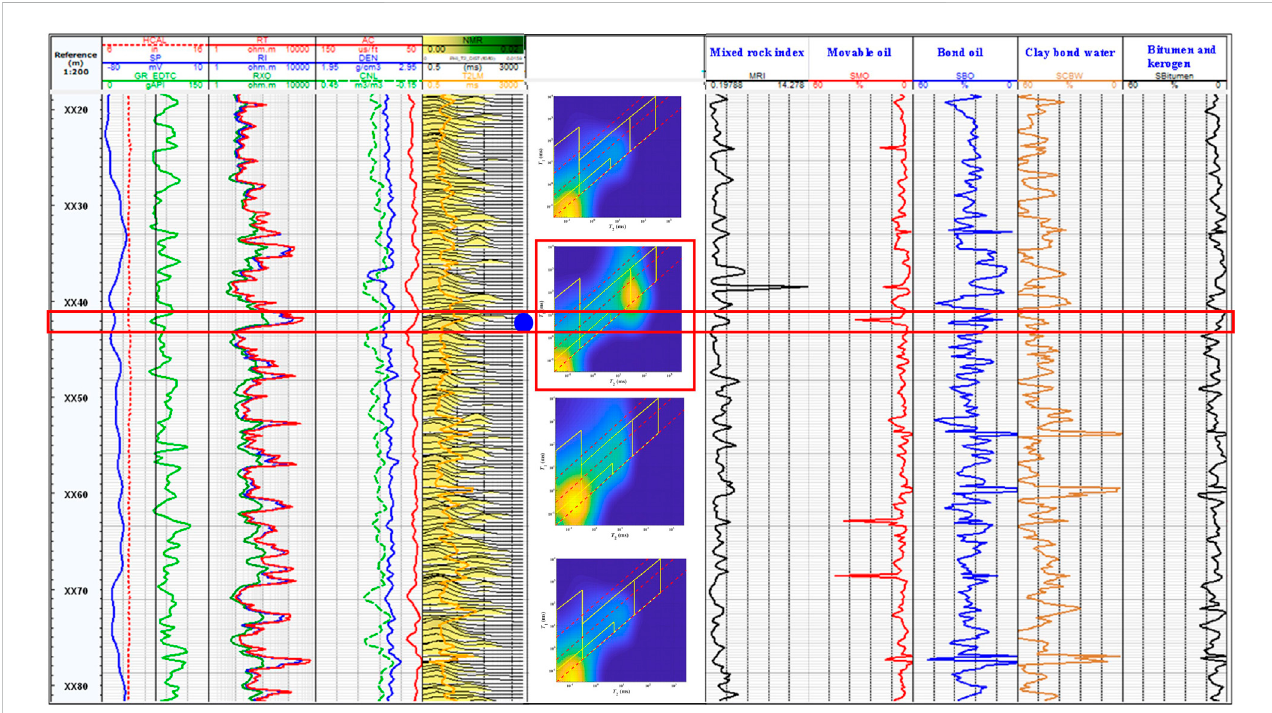
NMR logging evaluation results of Well W2. The fi rst track is depth. The second track includes the gamma (GR), SP, and caliper (CAL) logs. The third track includes the deep, medium, and shallow resistivity logs. The fourth track includes the acoustic (AC), density (DEN), and compensated neutron logging (CNL) logs.The fi fthtrackshowstheT2distributions(T2_DIST).Thesixthtrackgivesthemixedrockindex.Tracks7,8,9,and10aretheNMR fl uidsaturationfromthe method we